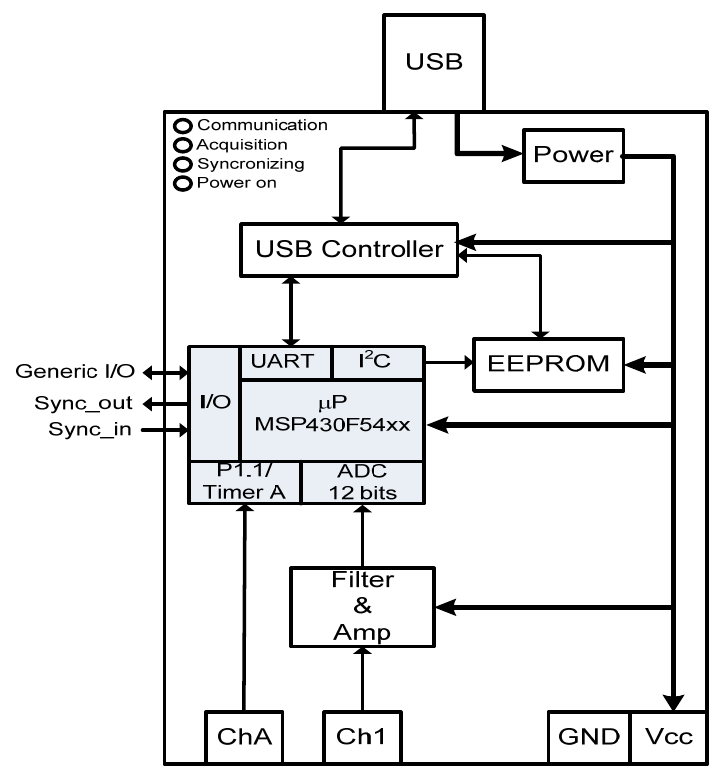
Figure 4. Diagram of the IS module